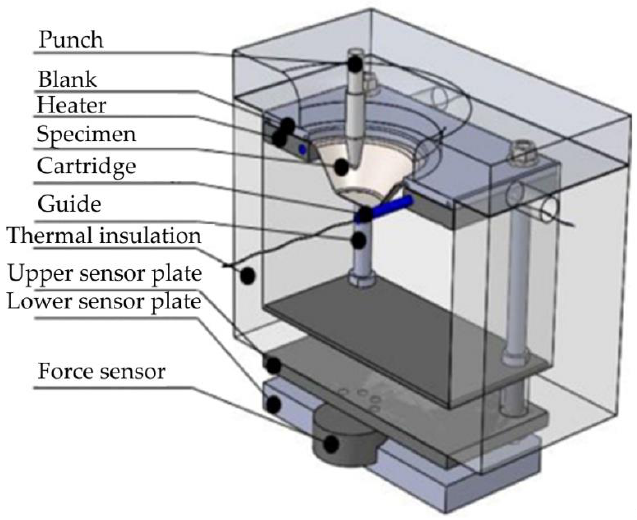
Figure 7. The device used in WSPIF (adapted with permission from Ref. [69], 2020, copyright The Brazilian Society of Mechanical Sciences and Engineering).